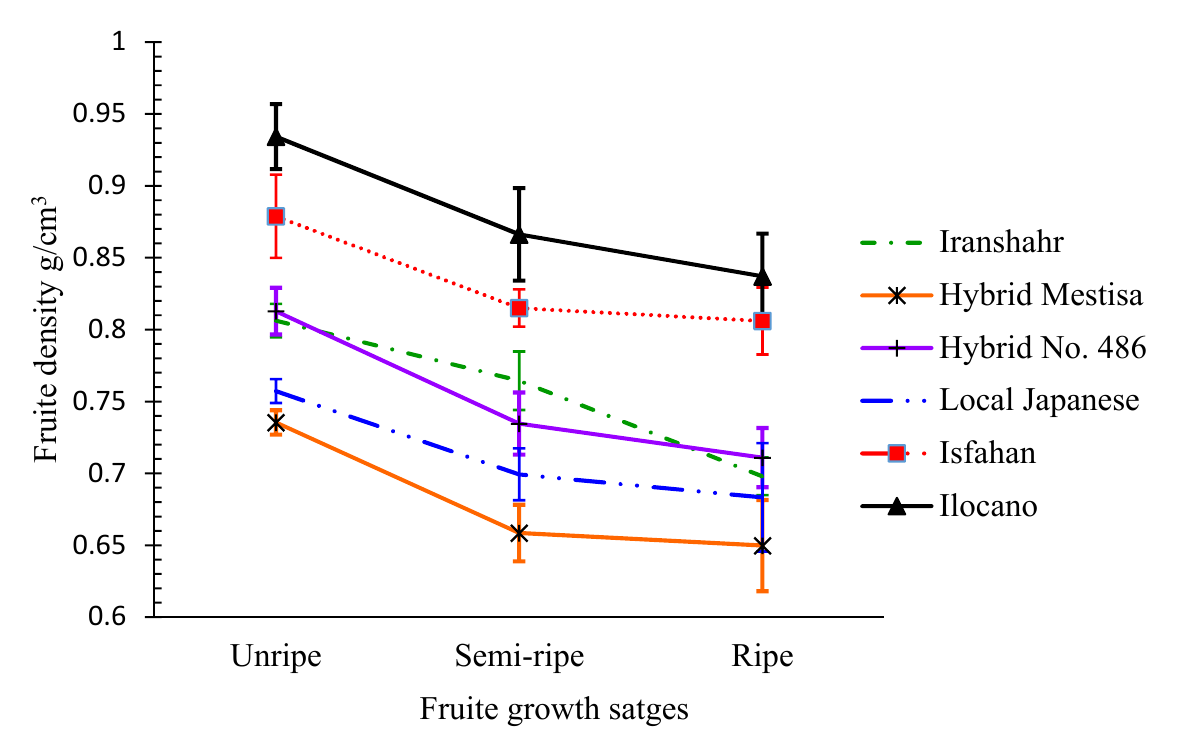
Figure 2. Changes in the fruit density of different bitter melon cultivars during fruit developmental stages from unripe to ariel color change stages. Table 4. Total seed number per fruit, 1000-seed weight, and color indices for six bitter melon cultivars.